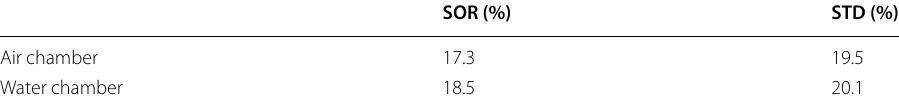
Table 7 Spill-Over Ratios (SORs) for the cold chambers in the NEMA image quality phantom SOR (%) STD (%) Air chamber